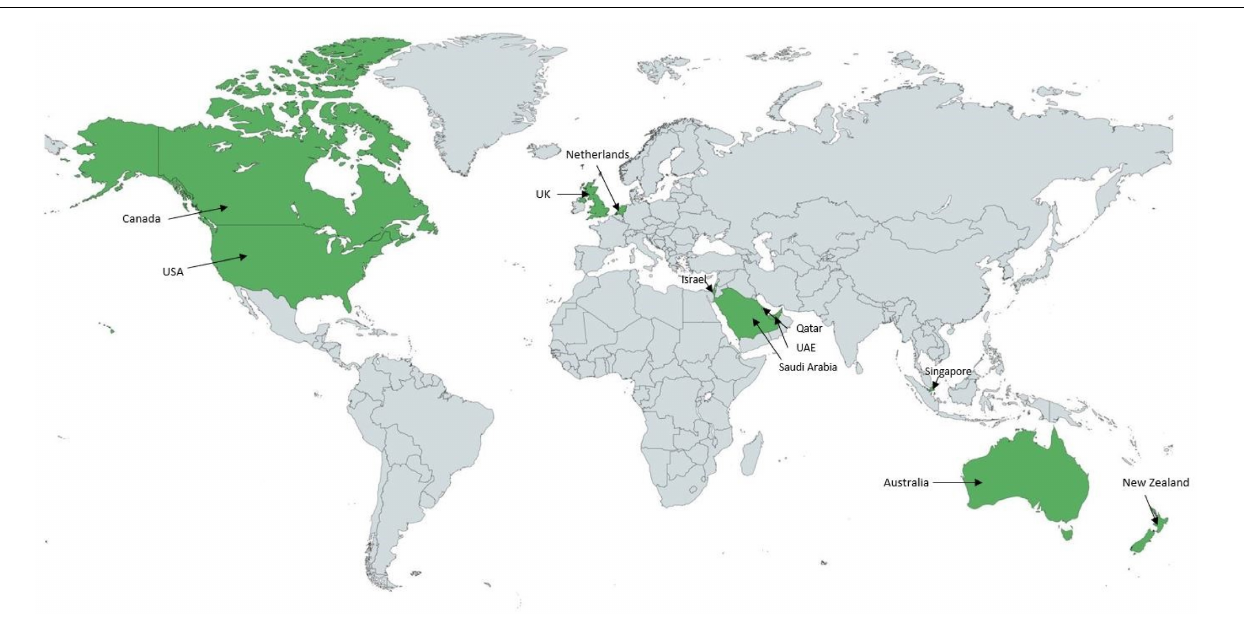
FIGURE 1 | World map representing the countries (in green) operating with a predominant sonographer model in the acquisition of pediatric echocardiograms. Applies to 11 countries to